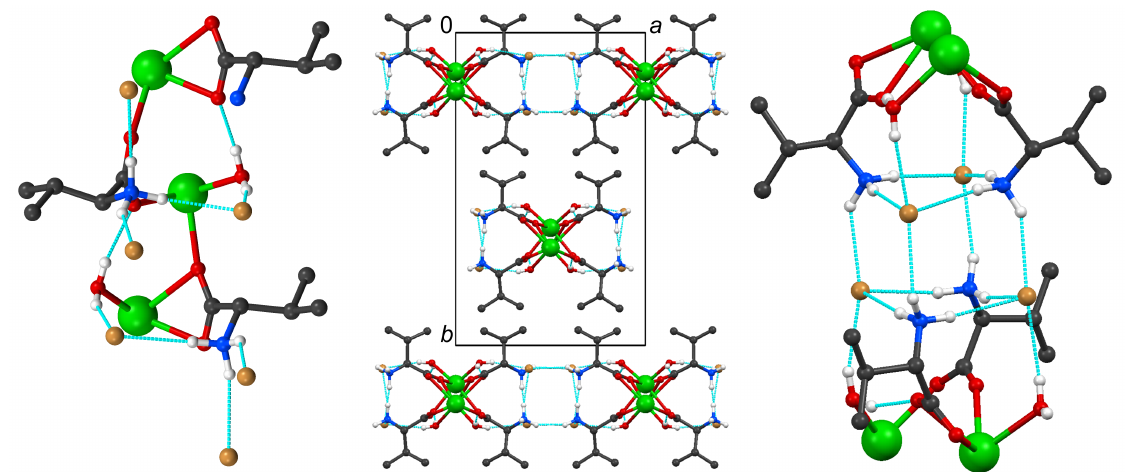
Figure 5. Left: Hydrogen bonds extending from the asymmetric unit of 2 . Middle: Resulting two dimensional network built by intermolecular hydrogen bonds in 2 . Right: Cube motif built by intermolecular hydrogen bonds in 2 .